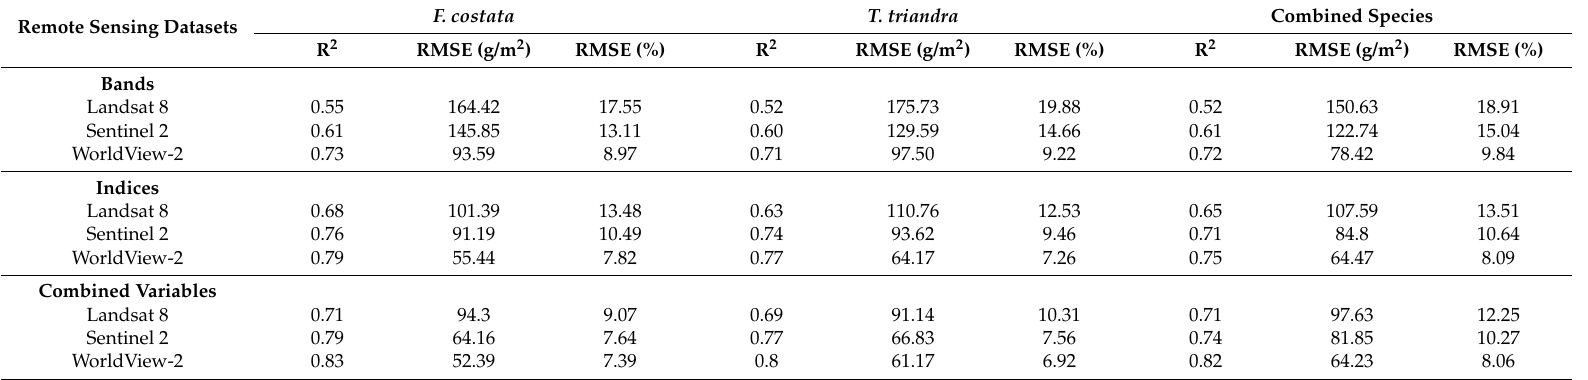
Table 5. Sensor AGB predictive accuracies for F. costata , T. triandra , and combined species. Remote Sensing